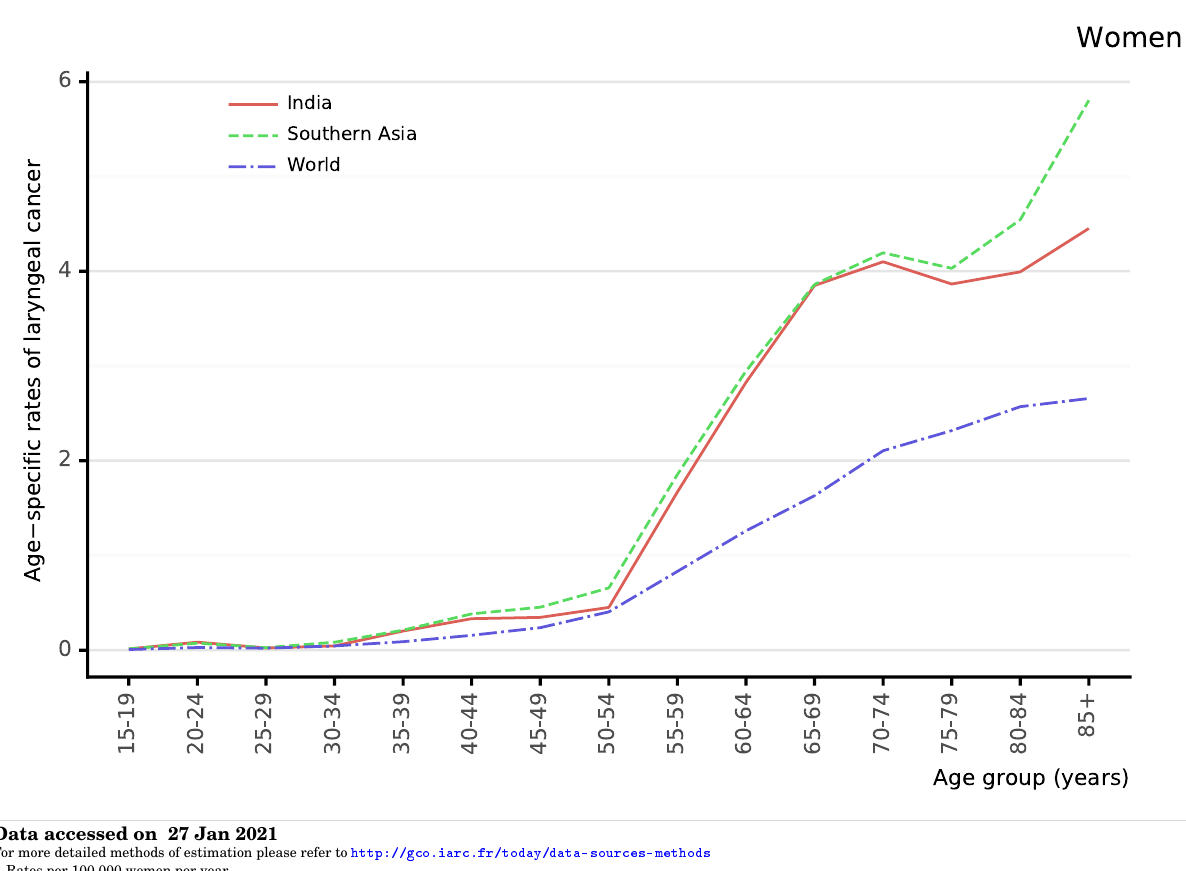
Figure 136: Comparison of age-specific laryngeal cancer mortality rates among women by age in India, within the region, and the rest of